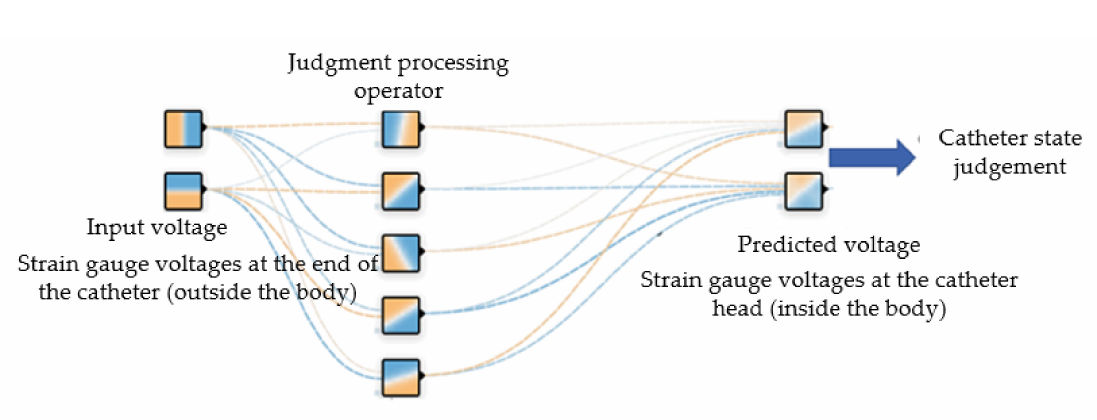
Figure 10. BP neural network structure